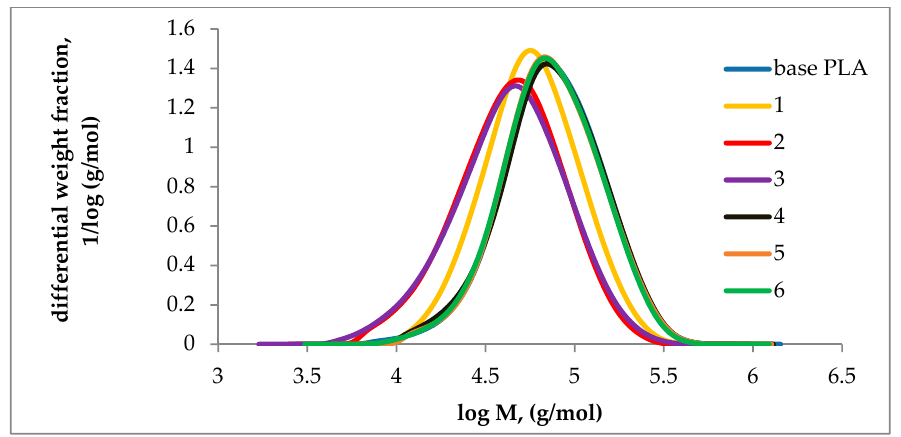
Figure 5. Molar mass distribution (MMD) curves of base and plasticized PLA.